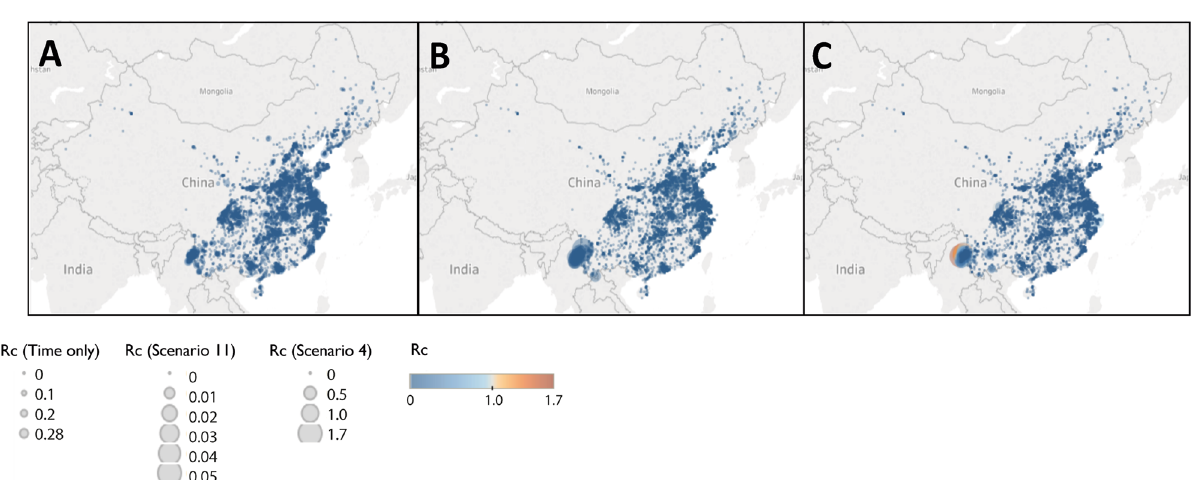
Figure 7. Map of Rc estimates for P. falciparum in China Map of ( A ) time-only ( B ) best scenario by AIC (Scenario 11) and ( C ) Scenario 4, representing an assumption of little long-distance transmission and few unobserved